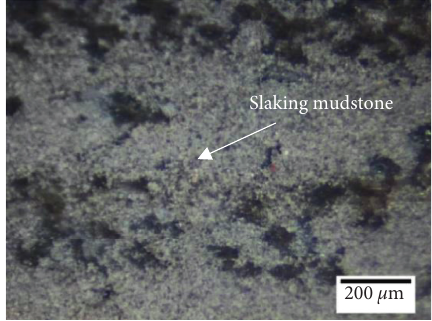
Figure 11: Slaking mudstone adhered to disc